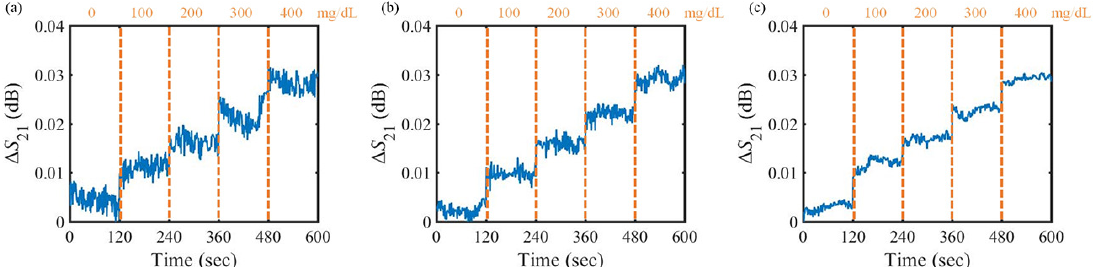
Figure 6. Measured result of the transmission coefficient variation under stable temperature condition. ( a ) 20 ◦ C; ( b ) 30 ◦ C; ( c ) 40 ◦